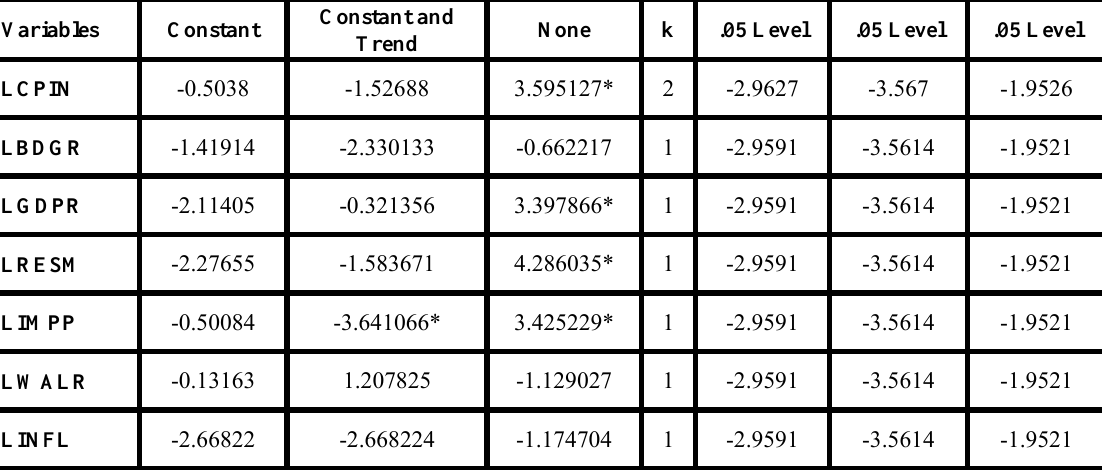
Table 1: Augmented Dicky-Fuller Test for Unit